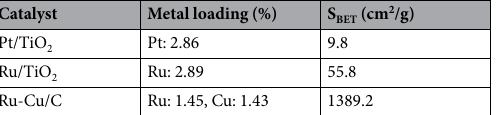
Table 1. The chemical composition and specific surface area of t Pt/TiO 2 , Ru/TiO 2 and Ru-Cu/C